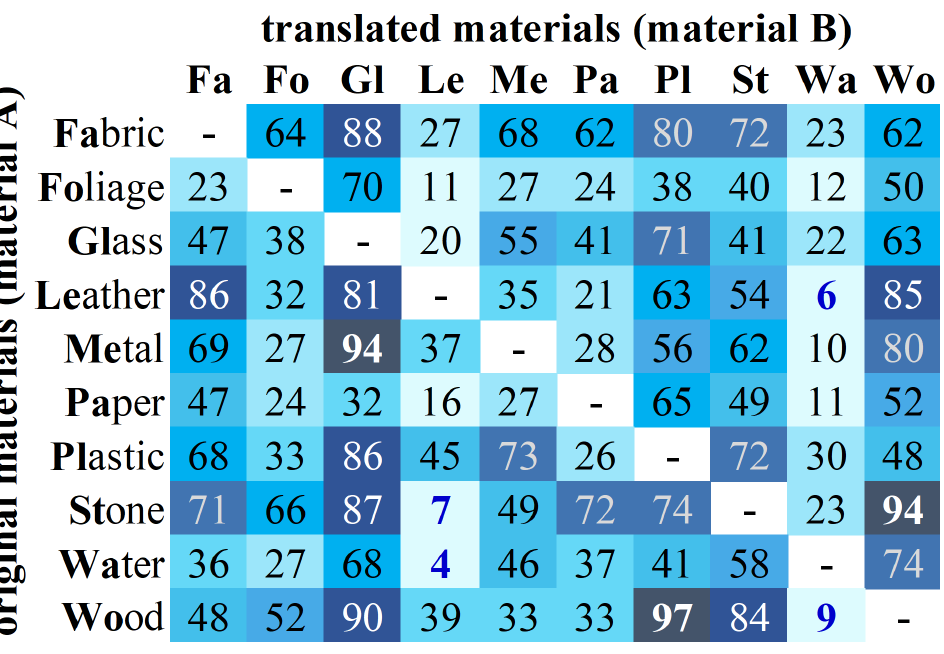
Figure 8. Classification accuracy (%) of translations from material A (rows) to material B